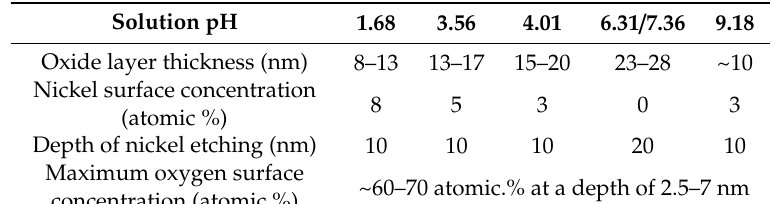
Figure 7. SEM image of the NiTi wire surface (mechanically treated in the direction of the long axis of the samples using diamond paste (3 µ m followed by 1 µ m)) after immersion for two years in Solution 2 (Table 1) at pH 3.56. Table 4. Surface composition of mechanically treated NiTi samples after immersion in various solutions for two years.